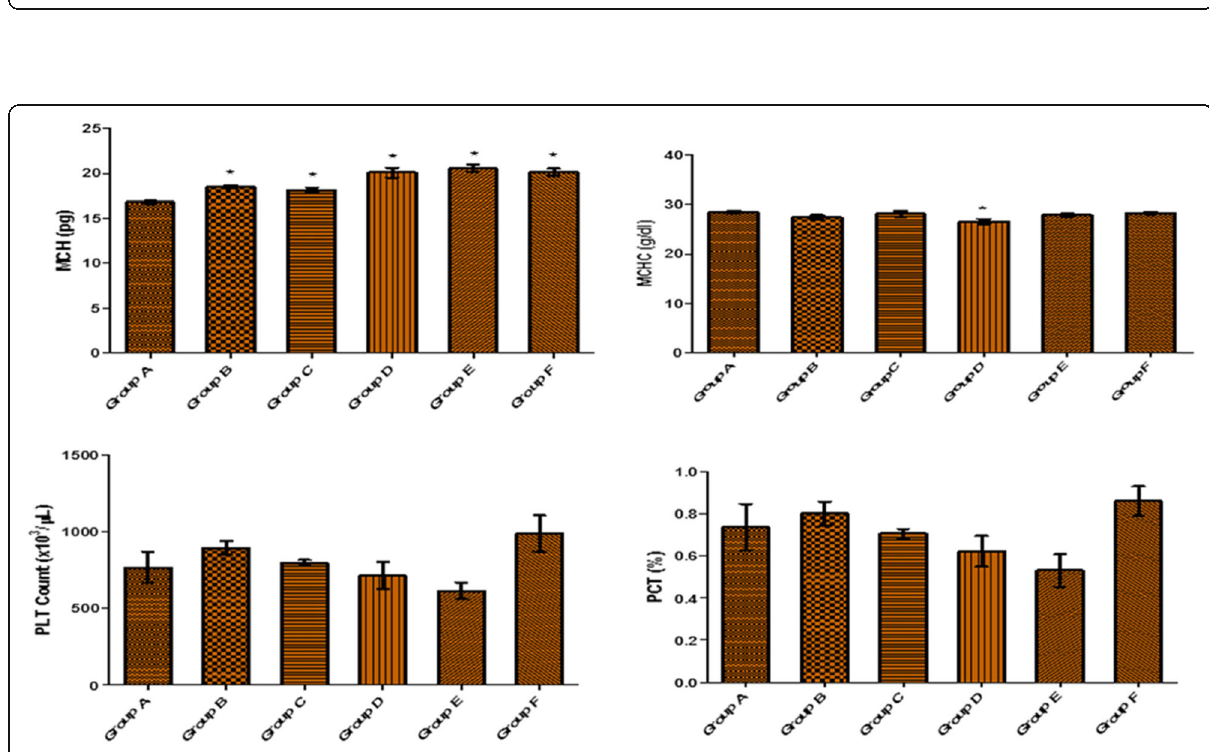
Fig. 3 Bar-charts showing the RBC (Red Blood Cell) count, haemoglobin concentration, haematocrit and the MCV (Mean Corpuscular Volume) of the experimental rats following the administration of Spondias mombin extract and PHZ at different doses